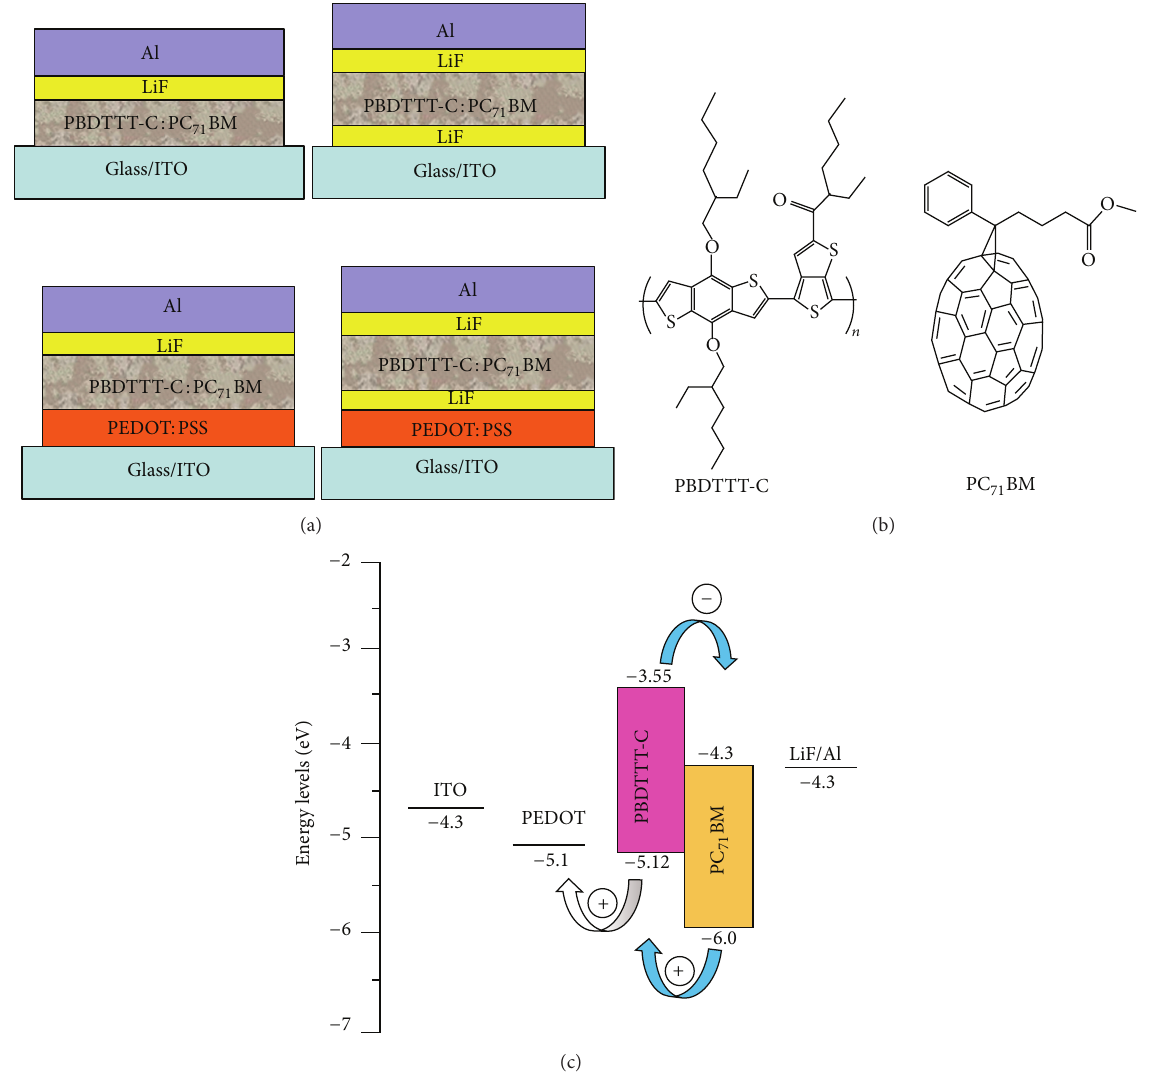
Figure 1: (a) The schematic architecture of the PSCs. (b) Molecular structure of PBDTTT-C and PC 71 BM. (c) The energy level structure of